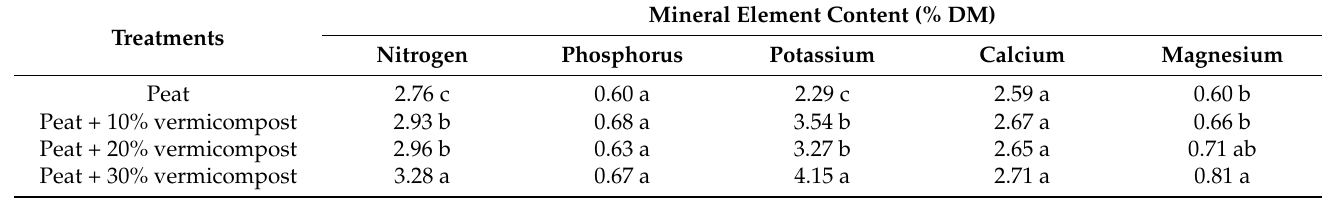
Table 3. The effect of peat–vermicompost substrates on mineral element content in the cucumber seedling leaves.